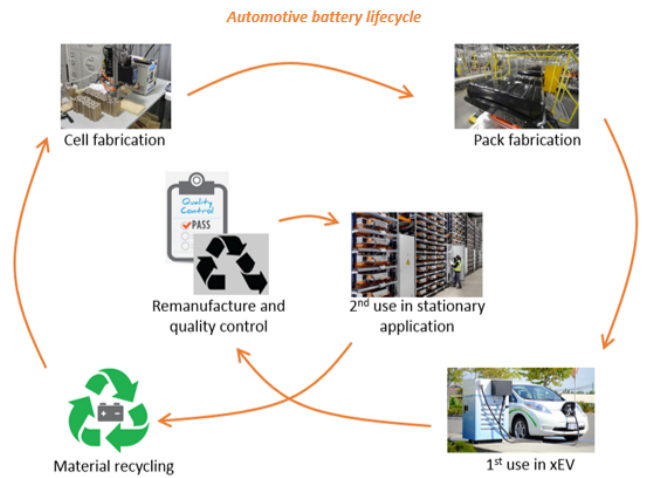
Figure 1. Life cycle of automotive battery